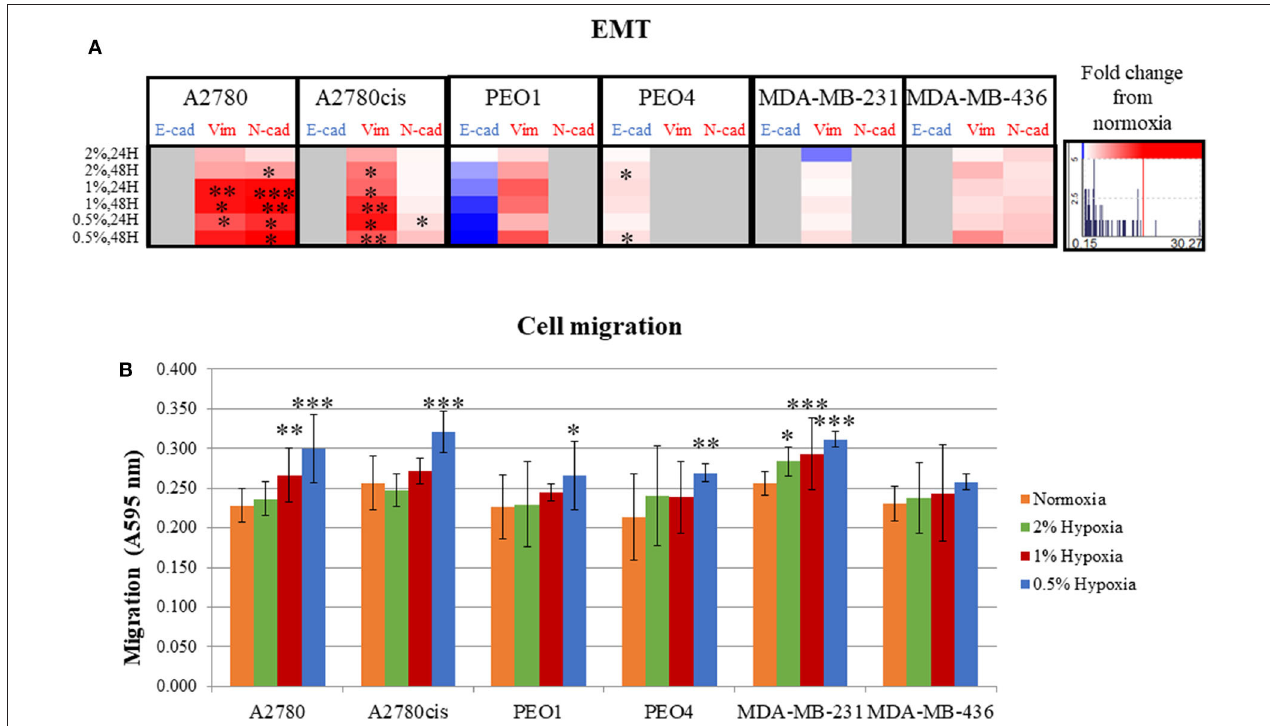
FIGURE 3 | Hypoxic exposure increases migration of breast and ovarian cancer cells; association with markers of EMT. (A) Fold change of the protein expression of E-cadherin, vimentin and N-cadherin as determined by densitometry (Image J)(Western blots are shown in Figure S3 ). Each condition was carried out on three biological replicates ( n = 3). (B) Quantification of absorbance readings from the Oris migration assay following hypoxic exposure. Cells were stained with Coomassie Instant Blue and the absorbance was read at 595nm. Error bars were calculated from 3 to 6 independent experiments with 4 technical replicates per experiment. Significant changes are starred: * P ≤ 0.05; ** P ≤ 0.01; *** P ≤ 0.001 ( T -test and ANOVA). The histograms on the right side of the figure are indicating increasing (in red) and decreasing (in blue) trends in EMT markers in hypoxia conditions comparing to